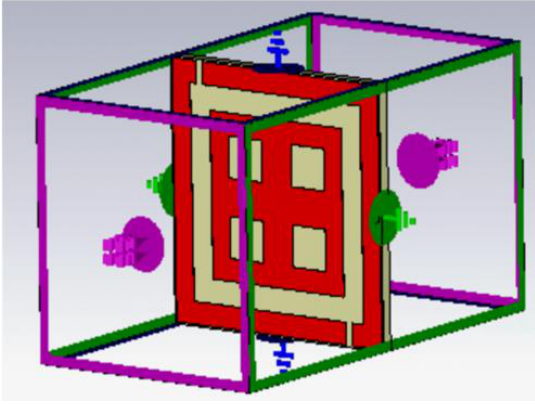
Figure 6. Boundary conditions of the designed unit cell.